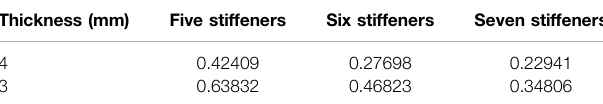
TABLE 6 | Maximum deformation of each model (mm).